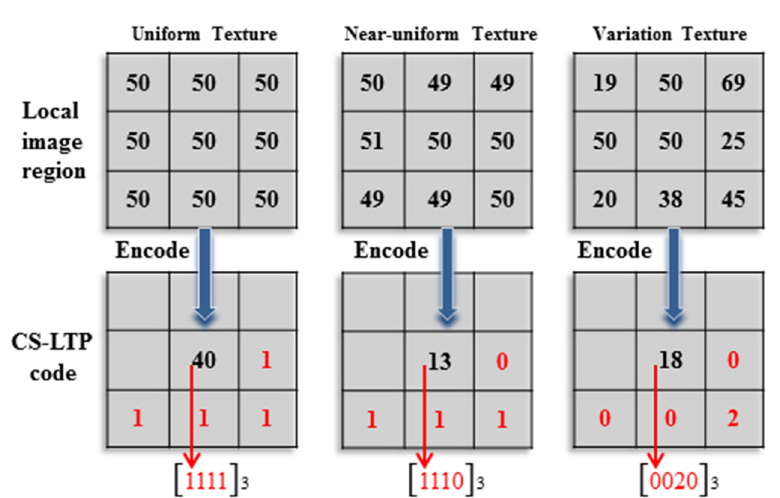
Figure 5. An example of CS-LTP encoding ( t =